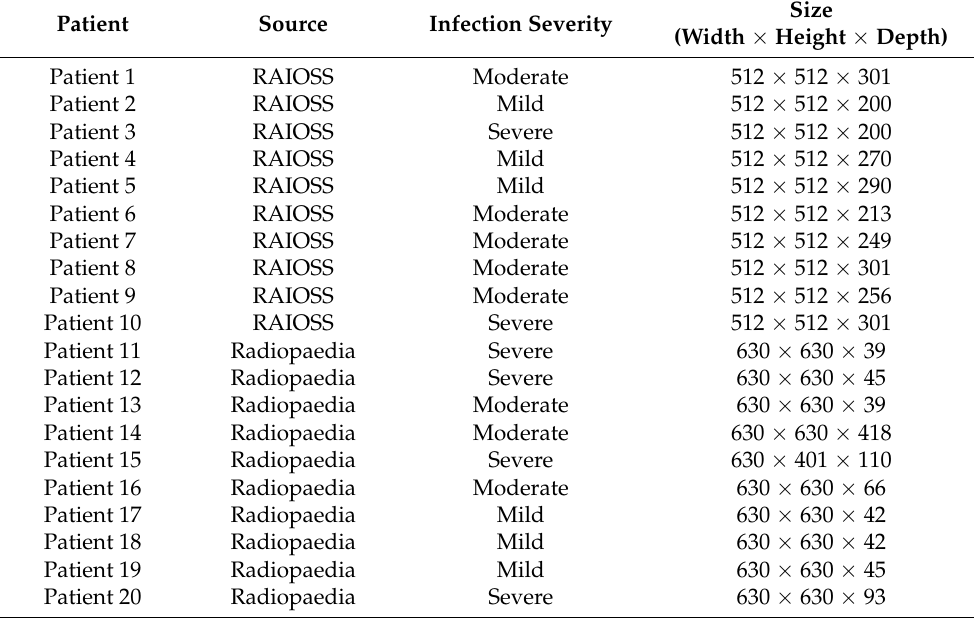
Table 3. Source, infection severity, and size information for each patient’s